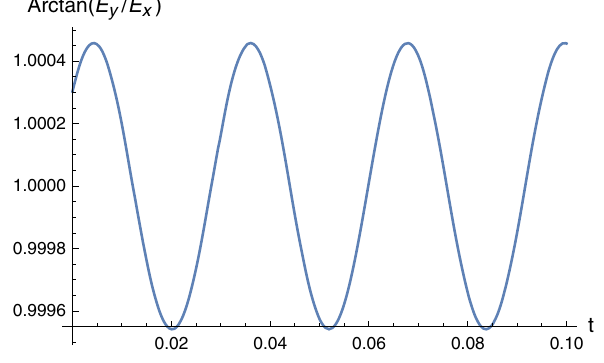
Fig. 2 The dynamical polarization of the electric fluctuations gener- atedbytheGWisrepresentedhereforafixedpositioninthe ( x , y ) plane. On the vertical axis we have arctan ( E y / E x ) normalized to the respec- tive value in the absence of GW and in the horizontal axis we have time in seconds. The GW parameters are a = 3 . 6 × 10 − 5 , b = 2 . 6 × 10 − 5 , w/ 2 π = 31 . 48 Hz, α = 0 . 26 π . We have used Eqs. (3.30) and (3.31), where for simplicity we assumed ˜ C 1 ( z , t ) = ˜ C 2 ( z , t ) = 1 and electric field magnitudes E 0 x = E 0 y = 10 − 3 V /